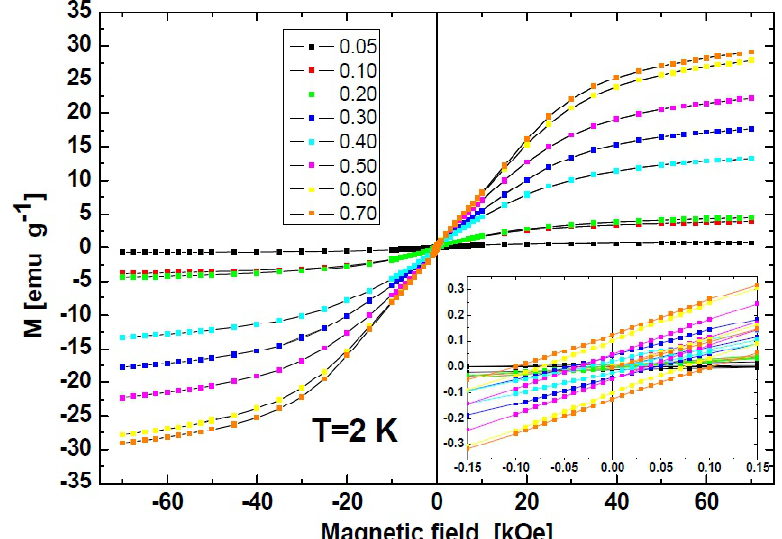
Fig. 8. Isothermal magnetisation M ( H ) (at T = 2K) for all investigated samples. The insert shows magnified central part of hysteresis